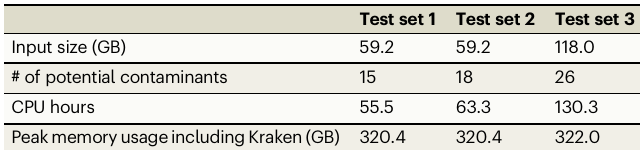
Table 1 | Run time and memory